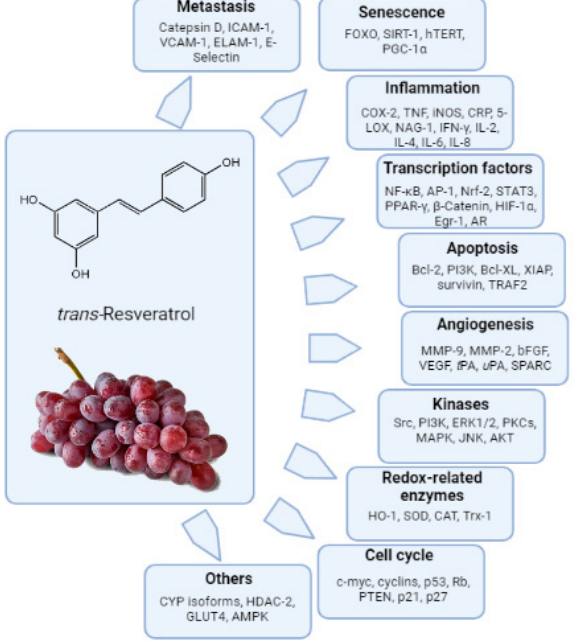
Figure 2. Resveratrol-modulated biochemical targets. AP-1, activator protein 1; CAT, catalase; CDK, cyclin dependent kinase; COX, cyclooxygenase; CRP, C-reactive protein; CYP, cytochrome P450; ER, estrogen receptor; ERK, extra cellularly regulated kinase; GPx, glutathione peroxidase; HIF, hypoxia inducing factor; hTERT, human telomerase reverse transcriptase; ICAM, intracellular adhesion molecule; IAP, inhibitor of apoptosis proteins; iNOS, inducible nitric oxide; MAPK, mitogen activated protein kinase; MMP, matrix metalloproteinase; NF κ B, nuclear factor kappa B; PI3K, phosphoinositide-3 kinase; Rb, retinoblastoma; SOD, superoxide dismutase; STAT, signal transducer and activator of transcription; SPARC, secreted protein acidic and rich in cysteine; TNF, tumor necrosis factor; VEGF, vascular endothelial growth factor.